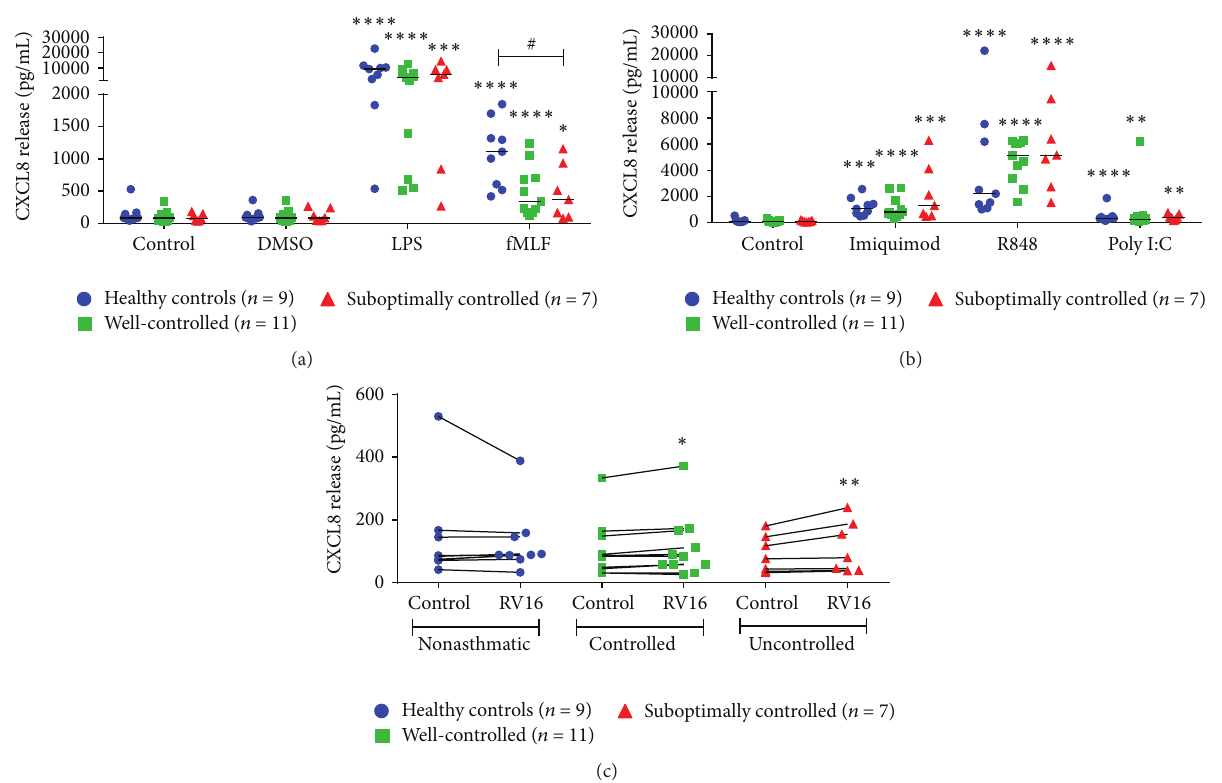
Figure 1: CXCL8 release from neutrophils stimulated with bacterial and viral mimetics and RV16. CXCL8 release from healthy controls (blue circles, 𝑛 = 9 ), well-controlled asthmatic (green squares, 𝑛 = 11 ), and suboptimally controlled asthmatic (red triangles, 𝑛 = 7 ) neutrophils stimulated with (a) bacterial compounds: lipopolysaccharide (LPS), f-Met-Leu-Phe (fMLF), and DMSO (vehicle control), (b) viral surrogates: imiquimod, R848, and polyinosinic:polycytidylic acid (poly I:C), and (c) RV16 after 24 hours. Raw data is presented as a scatter plot with median. ∗ 𝑝 < 0.05 , ∗∗ 𝑝 < 0.01 , ∗∗∗ 𝑝 < 0.001 , and ∗∗∗∗ 𝑝 < 0.0001 compared to unstimulated control. # 𝑝 < 0.05 between indicated